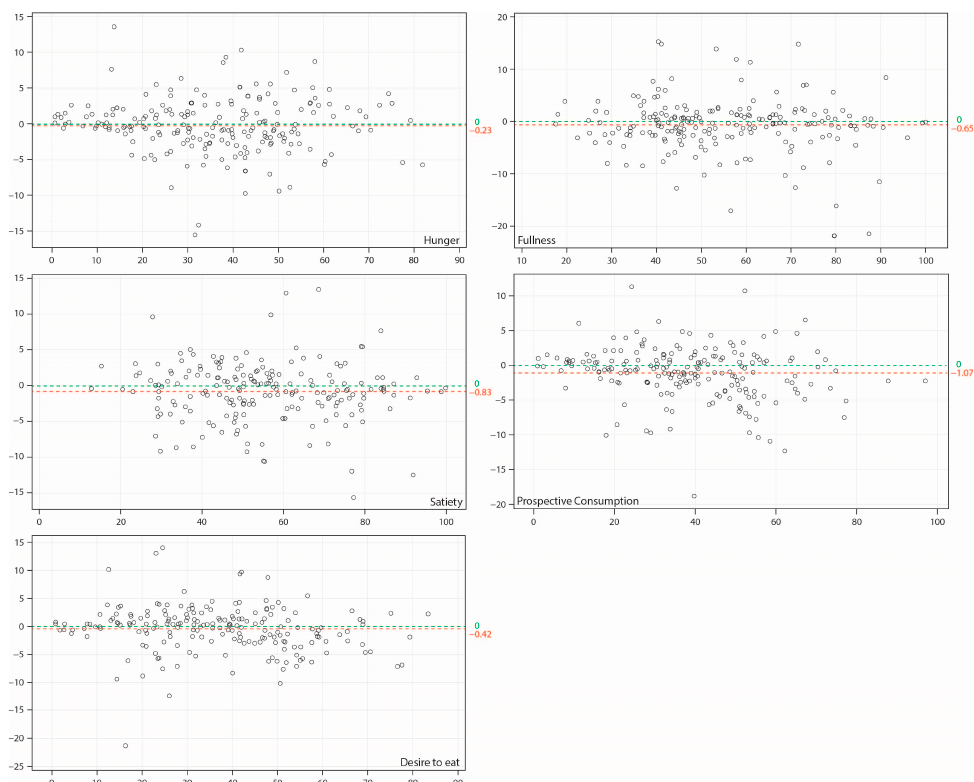
Figure 4. Bland and Altman plots for digital vs. paper visual analog scales for appetite measurement. The vertical axis refers to the mean difference in an appetite rating between digital and paper VAS; the horizontal axis refers to the mean of digital and paper VAS for that appetite rating. The green line indicates an ideal situation where there is zero difference between values measured by digital and paper VAS. The red line indicates the mean difference between values measured by digital and paper VAS.